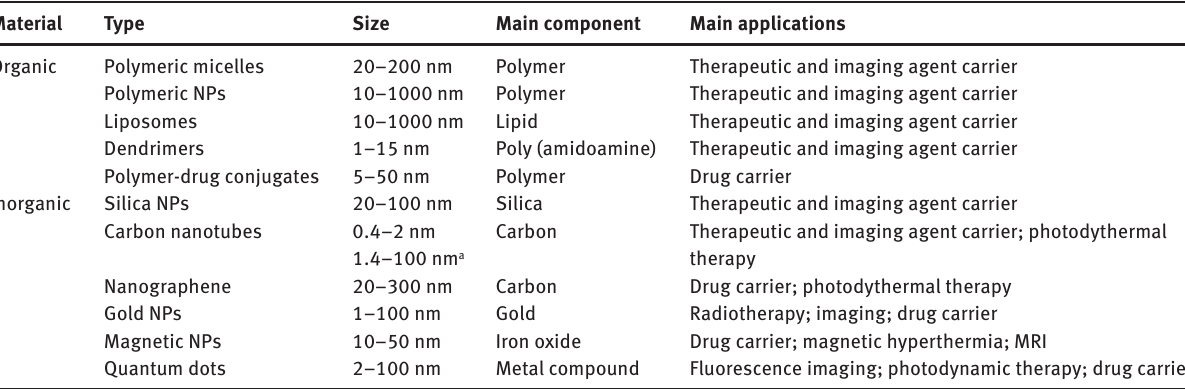
Table 1: Examples of nanomaterials for cancer therapies and imaging. Material